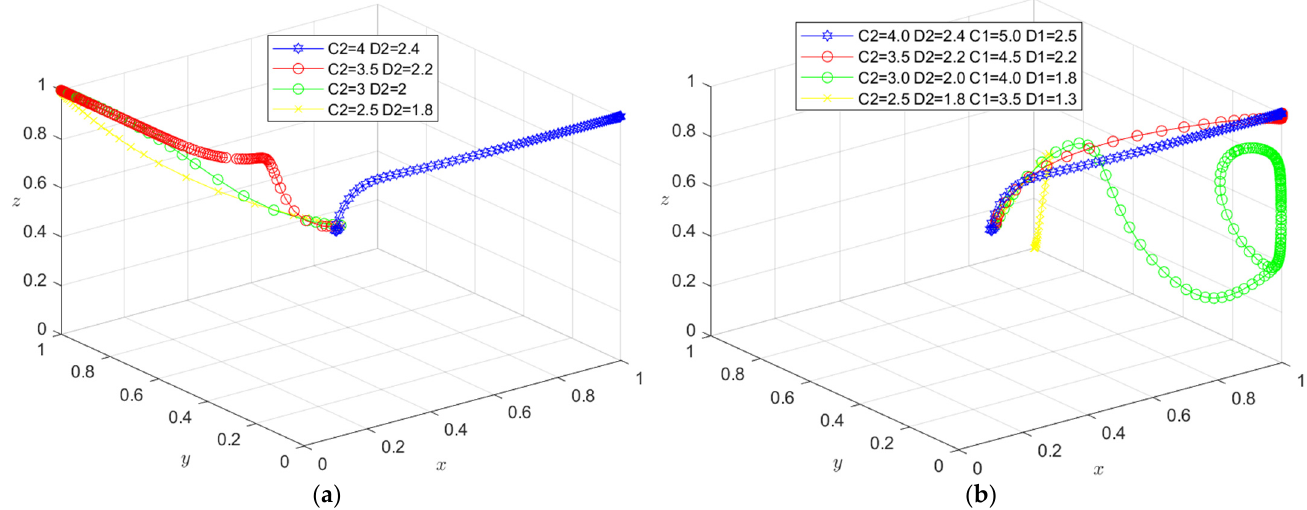
Figure 7. ( a ) Evolution path of the developer, general contractor, and government under different government punishments C 2 , D 2 . ( b ) Evolution path of the developer, general contractor, and government under different government punishments C 1 , C 2 , D 1 , D 2 .